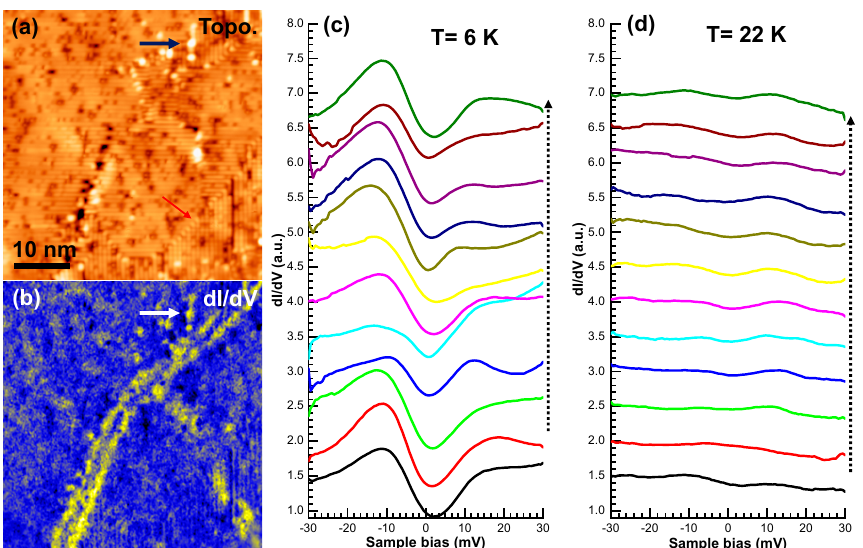
Figure 4. ( a , b ) STM image and dI/dV conductance map on a Pr-Ca122 region ( Vs = 300 mV, It = 200 pA, V ac = 1 mV, f = 973 Hz, T = 6 K). ( c , d ) dI/dV line spectra along the dotted arrow on the same area at 6 K and 22 K, respectively ( Vs = − 10 mV, It = 200 pA, V ac = 0.5 mV, f = 973 Hz). The same vertical offset is applied to the spectra in both ( c , d ). The red arrow points to a reconstruction of the domain boundary. It is important to note that the domain boundaries and defective regions where Pr dopants segregate are intrinsic bulk-like structures, which are created during crystal growth.